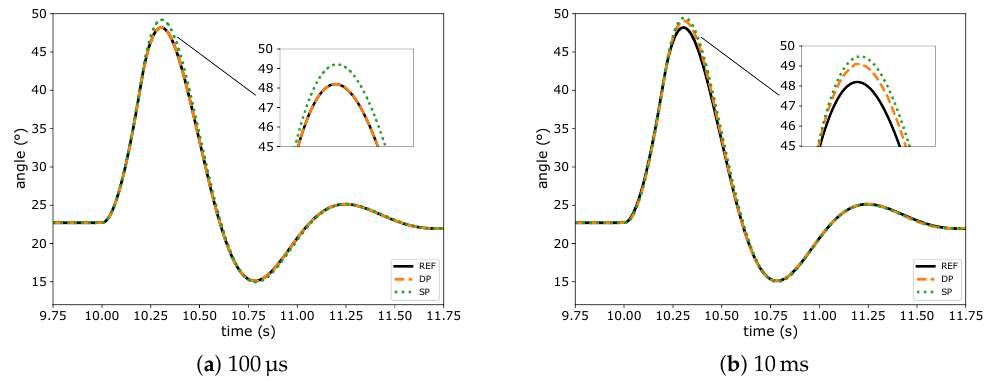
Figure 7. Synchronous generation rotor angle transient with classic inertia considering characteristic simulation step sizes of ( a ) 100µs and ( b )